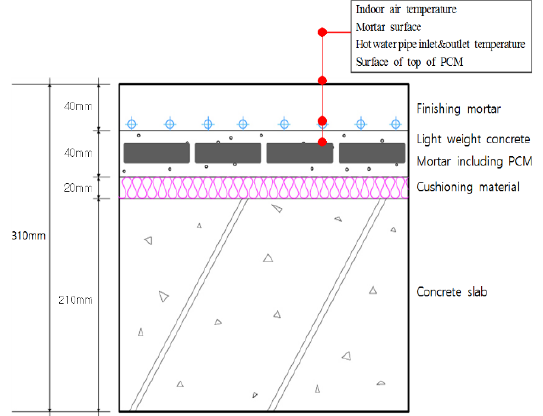
Molecules 2019 , 24 , 1352 Figure 7. Sensor locations in the conventional radiant heating system. Figure 7. Sensor locations in the conventional radiant heating system.